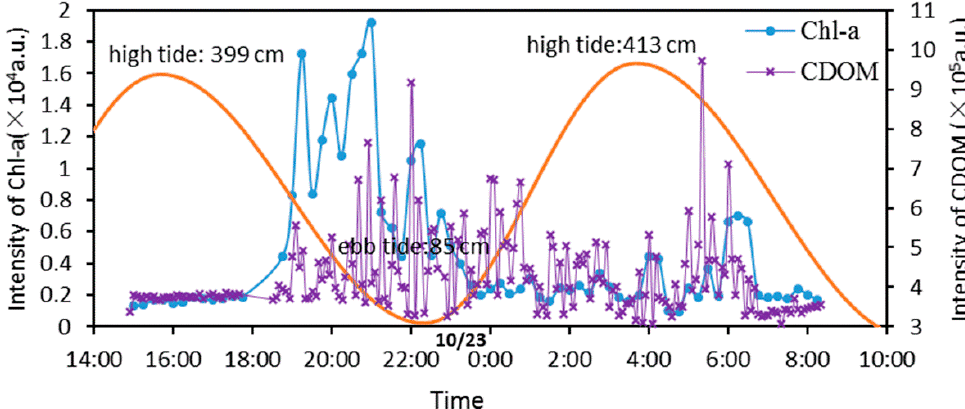
Figure 4. Diurnal variation of chl-a and CDOM fluorescence intensity. Blue symbols represent 15 min average intensity of chl-a, violet symbols indicate 5 min average intensity of CDOM. The orange line shows simulation of the tidal trend in the day, using tidal data from National Marine Data and Information Service as a reference.